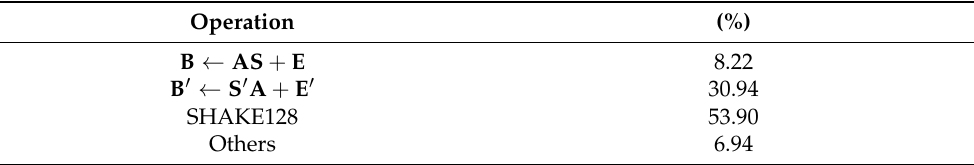
Table 1. The relative execution time of the FrodoKEM-640 scheme, in